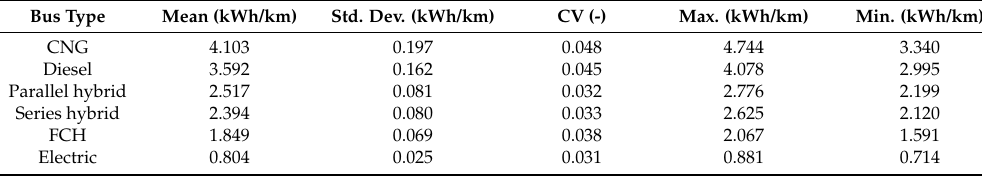
Figure 12. Energy consumption histograms of the simulated synthetic E11 driving cycles. Table 8. Simulated energy consumption distribution statistics on the synthetic cycles.